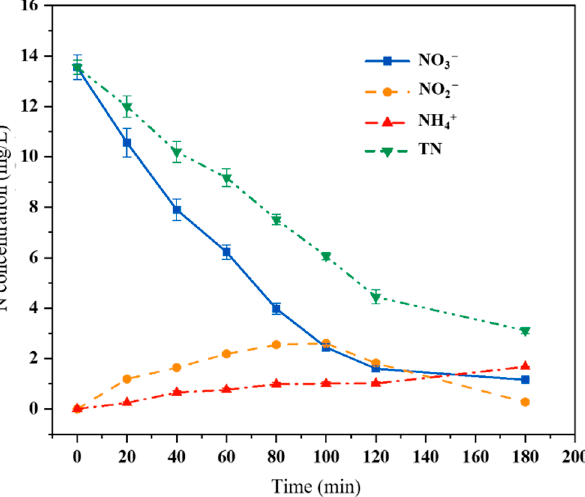
Figure 3. Formation of primary products during reduction of NO 3 ‒ in the UV/C 2 O 42 ‒ /Fe 3+ systems. Experimental conditions: [NO 3 ‒ ] 0 = 60 mg/L, [C 2 O 42 ‒ ] 0 = 3 mM, [Fe 3+ ] 0 = 0.05 mM, I 0 = 10.2 mW/cm 2 (wavelength = 365 nm), [DO] 0 = 0.5 ± 0.1 mg/L, pH ini. = 7.0 ± 0.2, and T = 25 ± 0.5 °C. Error bars represent the standard deviation from three experiments. Error bars smaller than symbols are not visible.